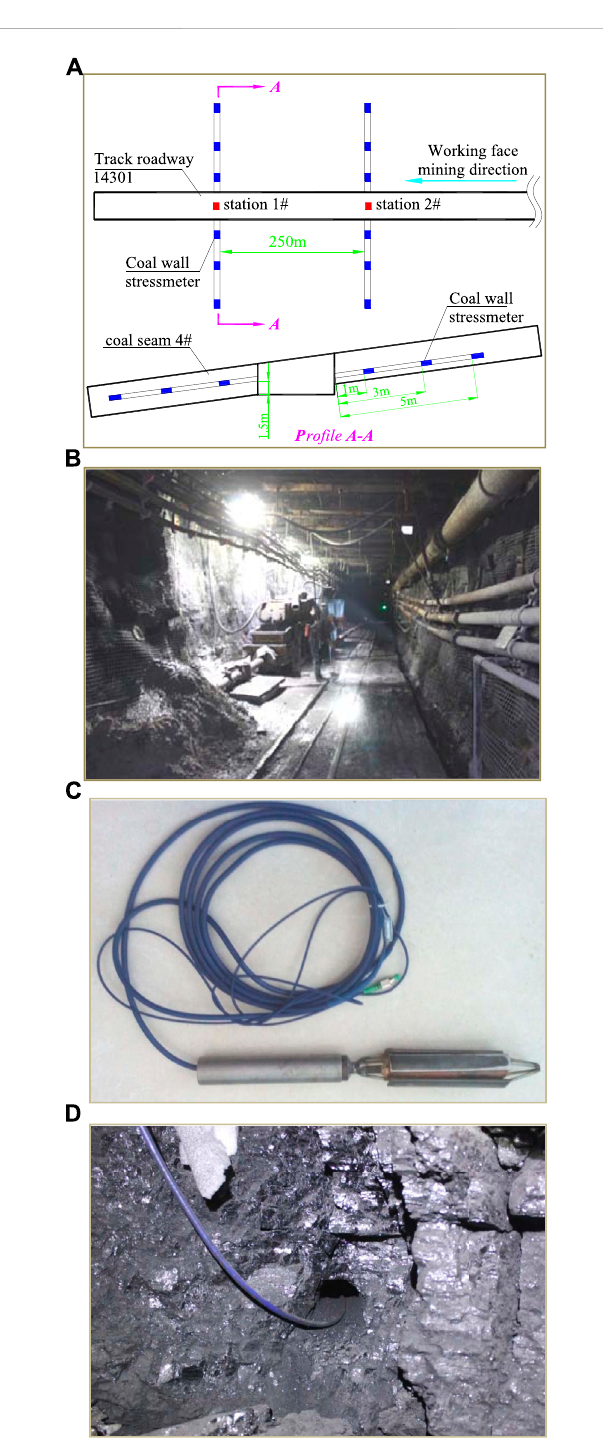
FIGURE 18 Field installation and layout of the CS-FBG borehole stress meter. (A) Layout designofboreholestressmeter. (B) Site construction drawing of borehole. (C) CS-FBG borehole stress meter. (D) Field installation of roadway sides.